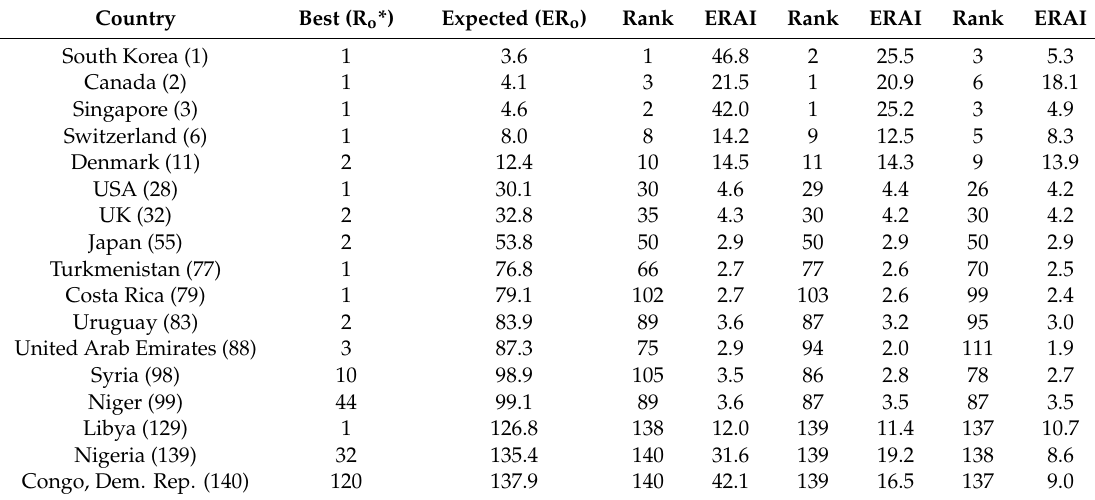
Table 10. Best and expected ranks for selected countries obtained by the simulation-based Monte Carlo analysis. The three highest e ffi ciency rank acceptability indices (ERAI) are shown with their corresponding ranks. The ERAIs are expressed in %. The number in parenthesis after a country’s name is its overall rank according to the expected rank ER0. The full table for all countries is available in the ESI, Table